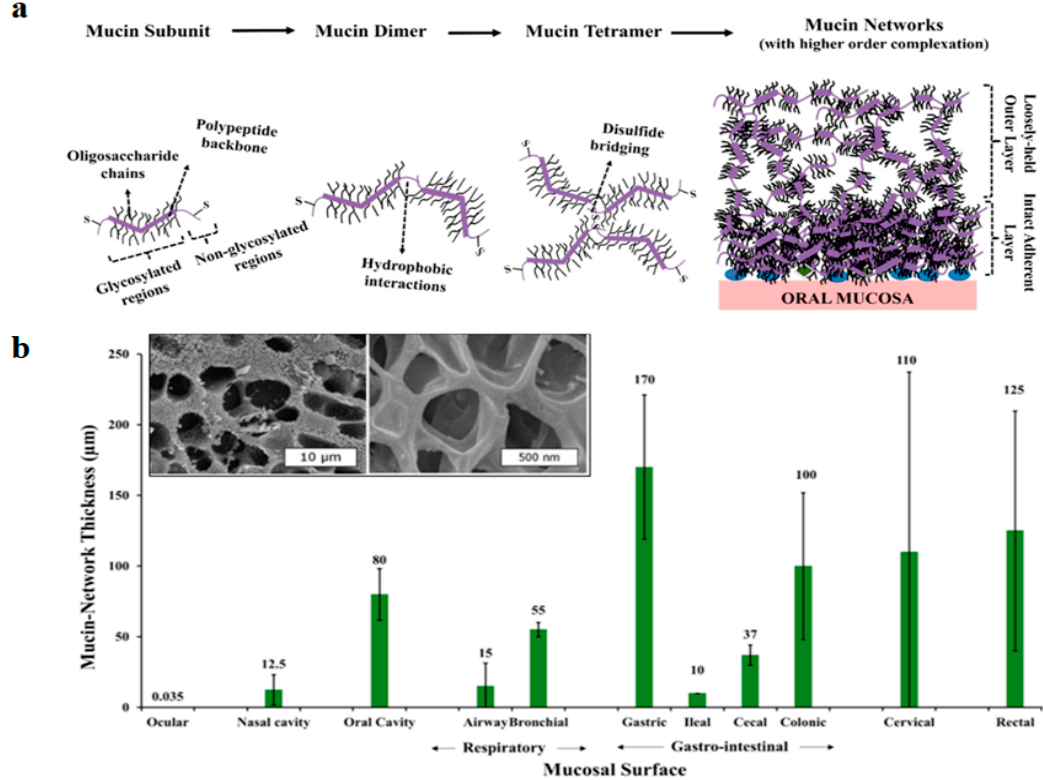
Figure 1. Characteristics of the mucin network from different mucosal surfaces. ( a ) Progression of higher order complexation of mucin glycoproteins resulting in the formation of a mucin network over an oral mucosal surface. This scheme demonstrates the progression of a high-order complexation process, which results in the formation of mucin aggregates. Mucin aggregates invariably contain two-distinct zones: the more intact adherent mucin layers, and loosely-held (expanded) mucin layers of high free-volume. ( b ) Mucin network thickness in the respiratory and gastrointestinal mucosa; thickness is expressed in µm. Mucin network thickness varies according to its physiological location and role. Inset figure shows cryo-SEM imaging of pulmonary mucin, demonstrating heterogeneous mesh size distribution [29].